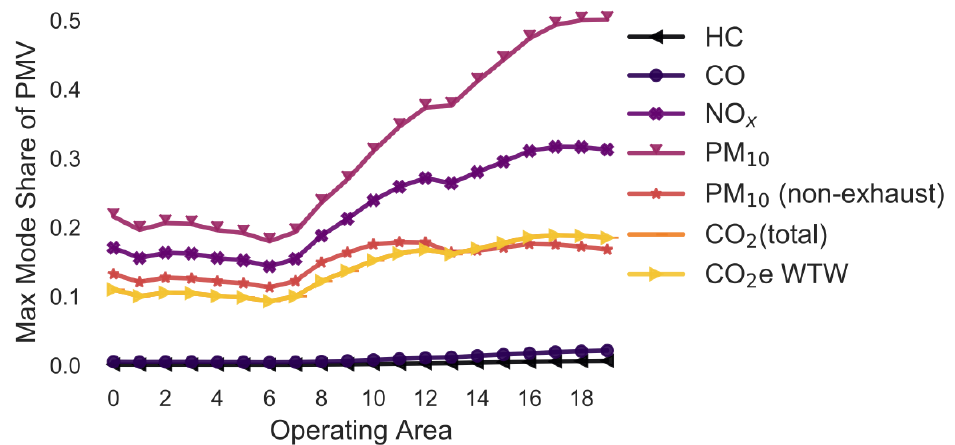
Figure 13. Maximum share of customers who can pick up a parcel by car (varying parking duration before customer trip) (note: CO 2 (total) and CO 2 e WTW are the same).